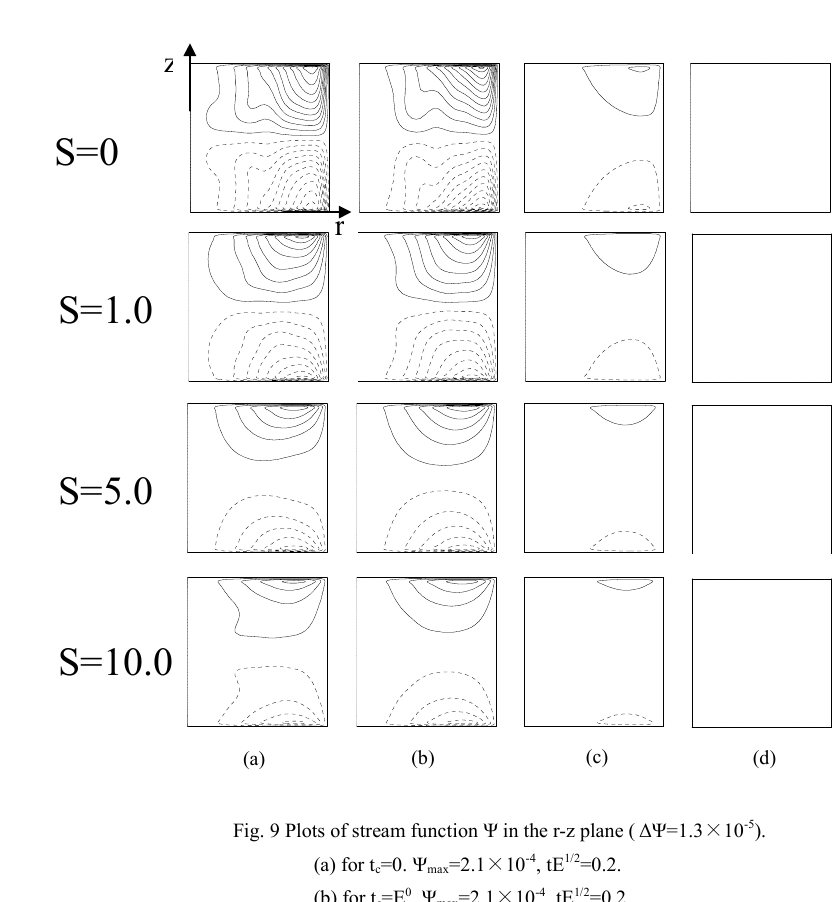
Fig. 9 Plots of stream function Ψ in the r-z plane ( ∆Ψ =1.3 × 10 -5